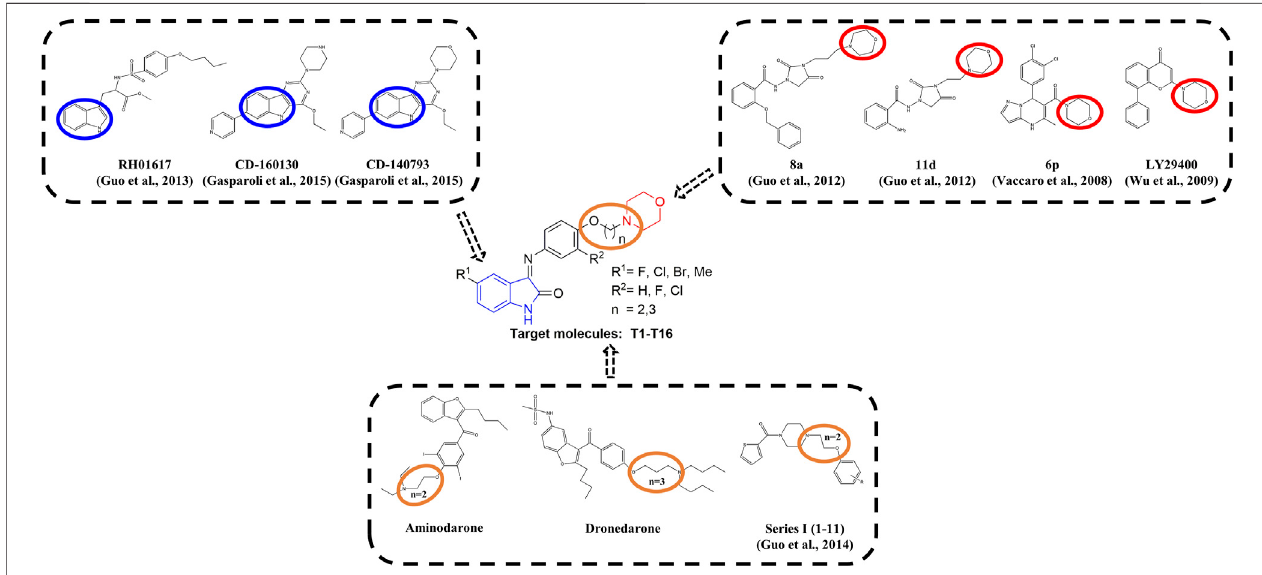
FIGURE 1 | Design strategy of novel Kv1.5 inhibitors based on morpholine, 1 H -indole, and the active linker (-N(CH 2 ) n O-).